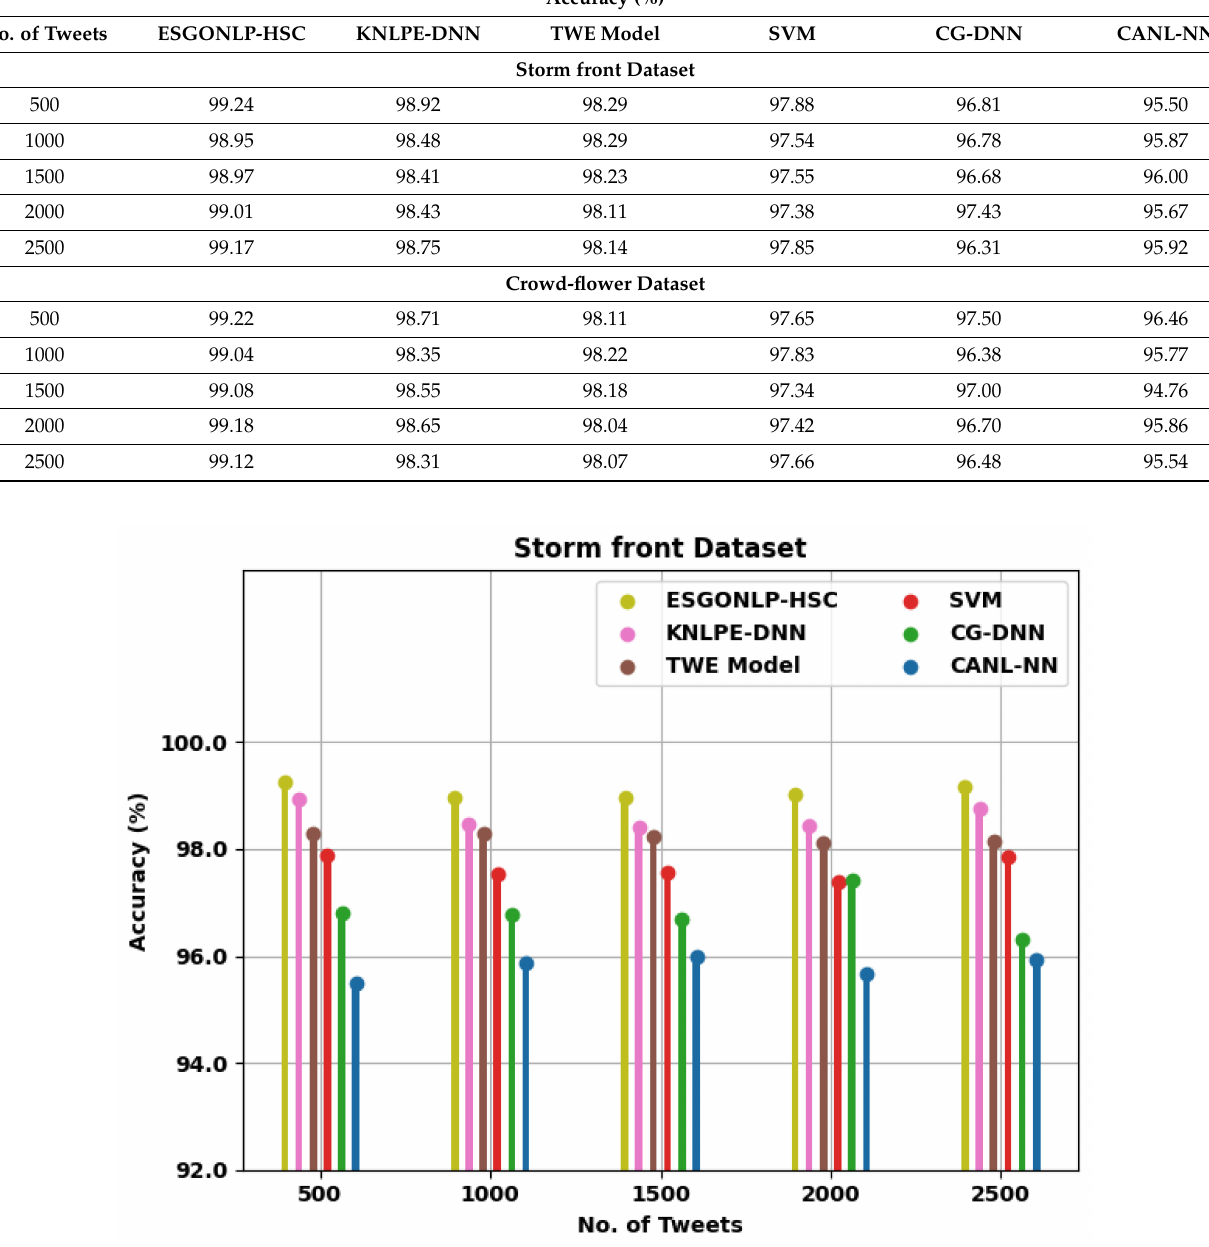
Figure 3. Accu y analysis of ESGONLP-HSC technique under Storm front dataset. Table 3 offers a brief relative precision examination of the ESGONLP-HSC technique